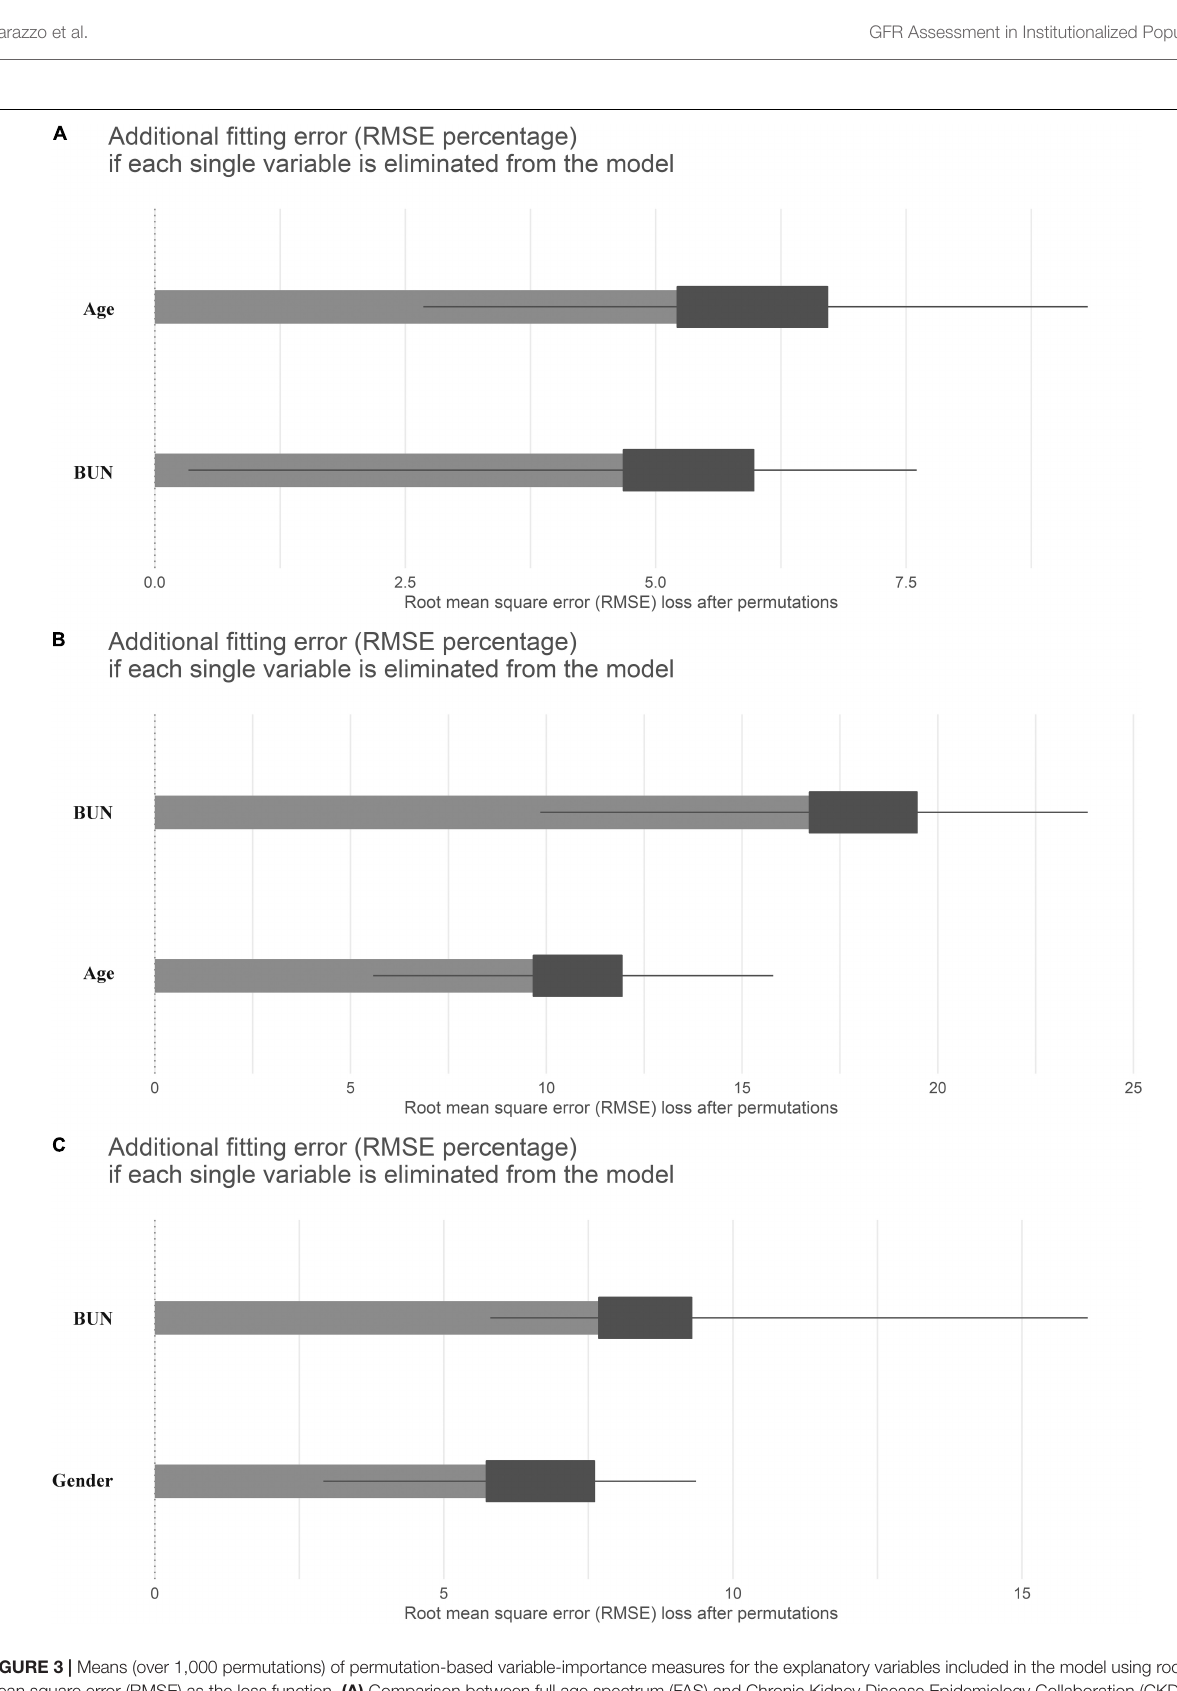
Frontiers in Medicine |